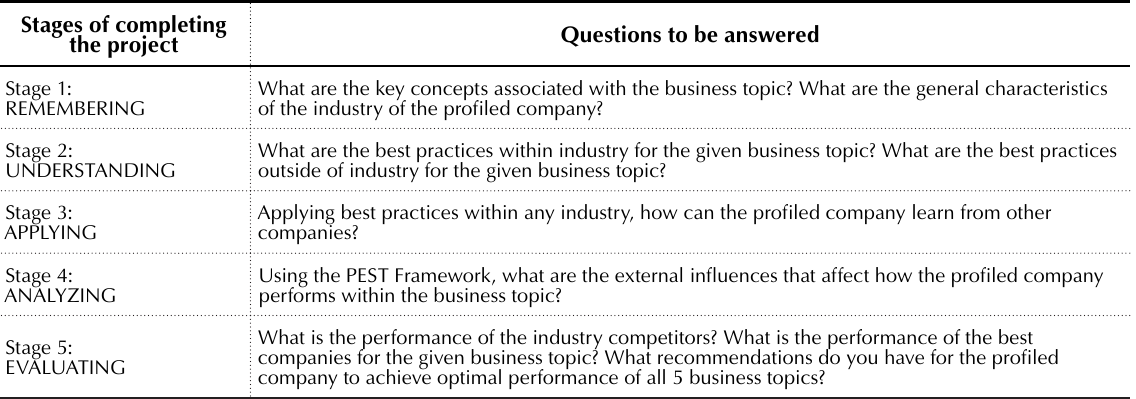
Source: Introduction to Business, U.S. Coast Guard